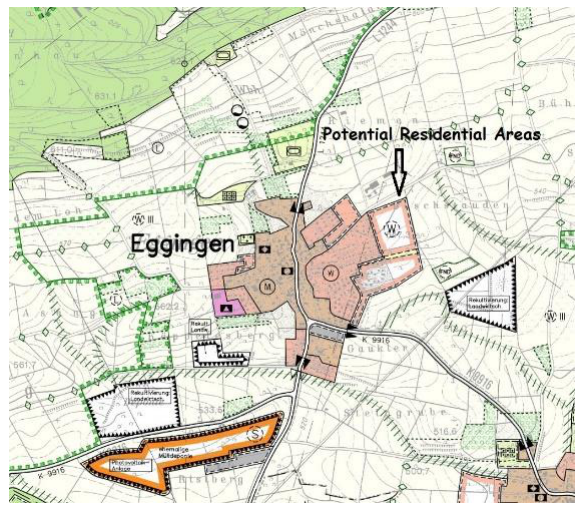
Figure 2 : Land Use Plan of Eggingen District